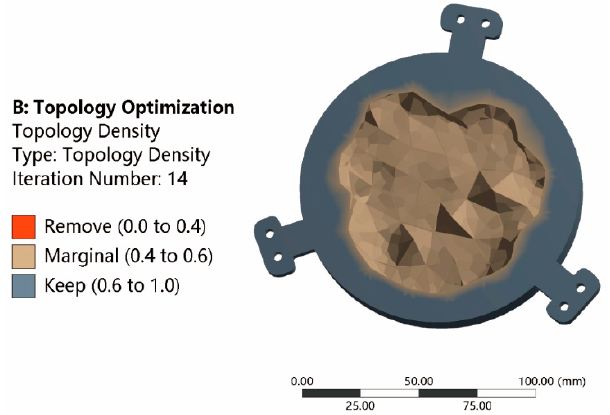
Figure 7. The results of the topological optimization (back of the mirror).